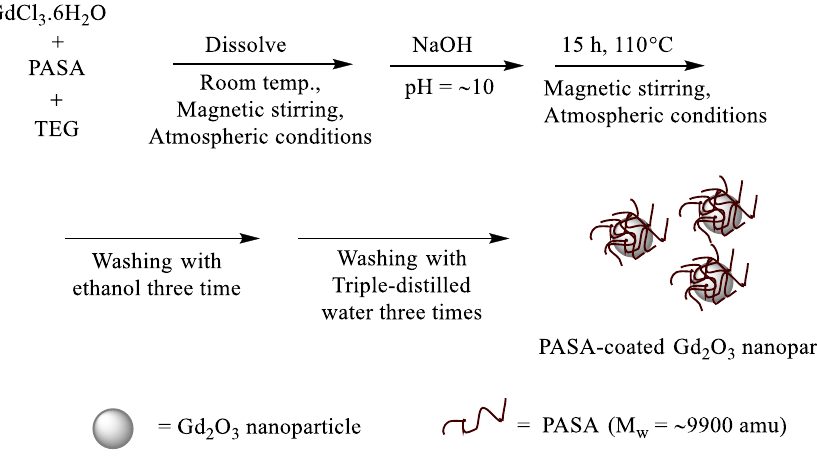
Figure 1. One-step polyol synthesis of PASA-coated Gd 2 O 3 nanoparticles.